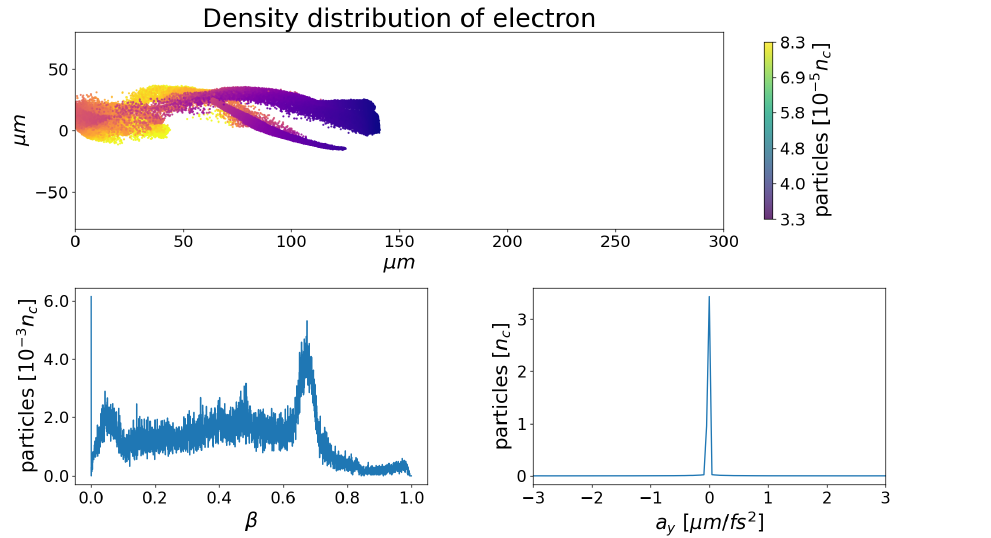
Figure 27. Oscillating electrons. The top figure is the electron density distribution shown by color. The bottom left figure is the velocity distribution in β = v / c , where v is the velocity of the electron and c is the speed of light. bottom right of the figure shows the acceleration of the electrons in the y -axis. This distribution has a tail that extends into the non-relativistic region. We expect that they would emit photons through synchrotron radiation, which can affect the identification of the Hawking photon